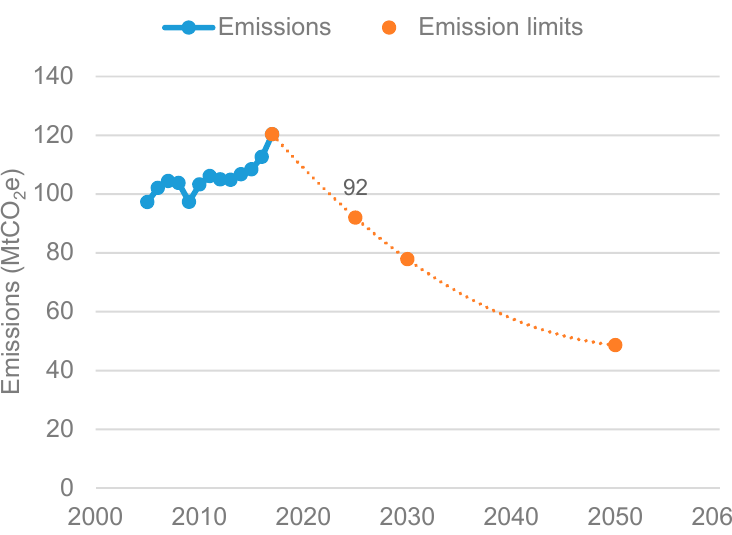
Figure 2. Forecast electricity demand and power supply for 2017–2031 (pumping energy excluded).